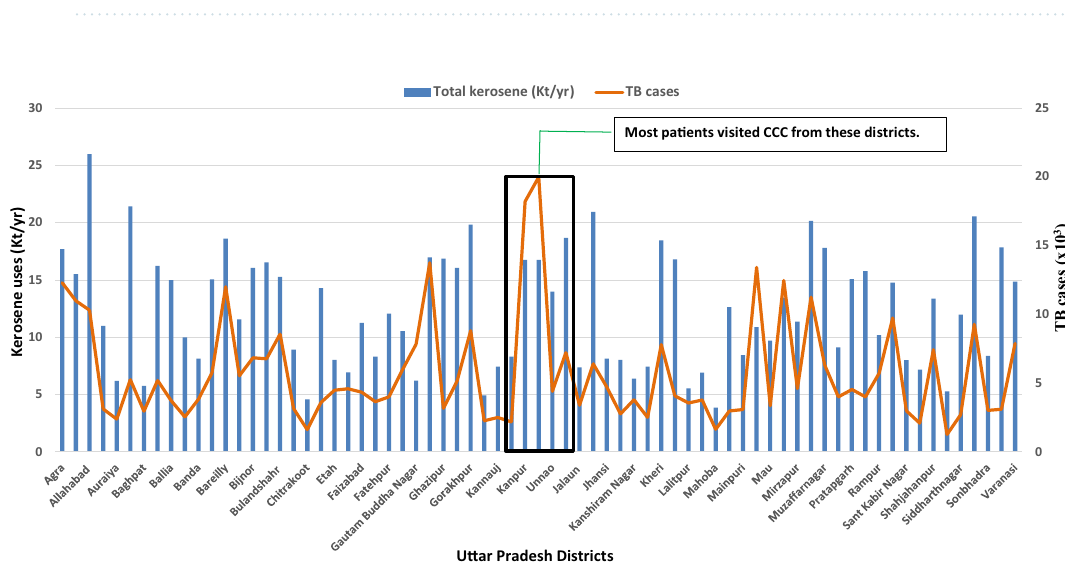
Figure 4. District-wise Uses of kerosene 65 (Kt/year) and TB cases in the state of Uttar Pradesh 51